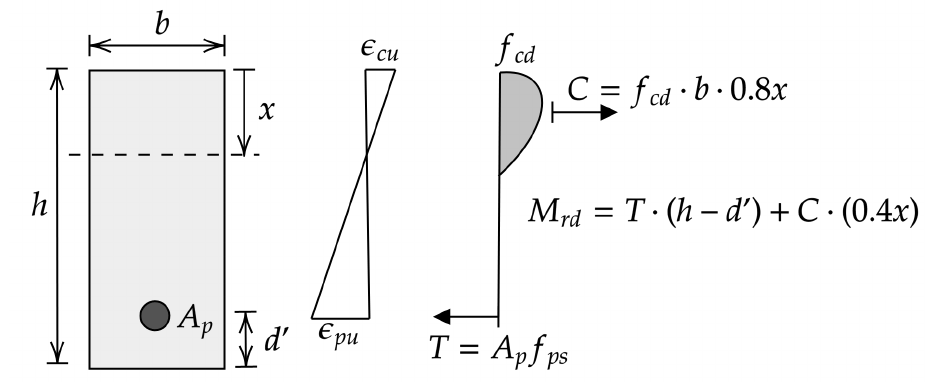
Figure 1. Evaluation of the resisting bending moment of a prestressed beam, where (cid:101) cu and (cid:101) pu are the ultimate deformations of concrete and the prestressing cable, f cd is the design concrete stress and f ps is the design tensile stress of the prestressing cable, M rd is the resisting design